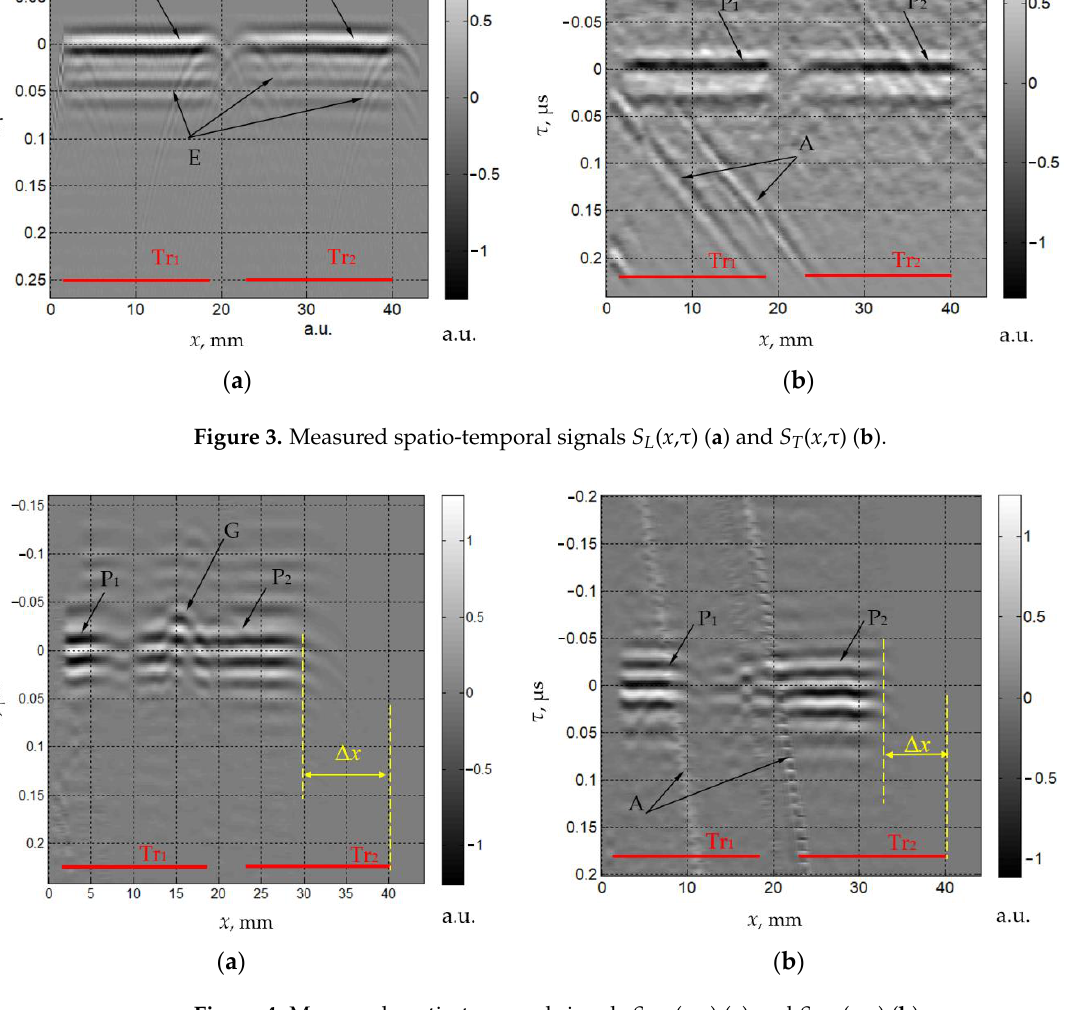
Figure 3. Measured spatio-temporal signals S L ( x ,τ) ( a ) and S T ( x ,τ) ( b ).